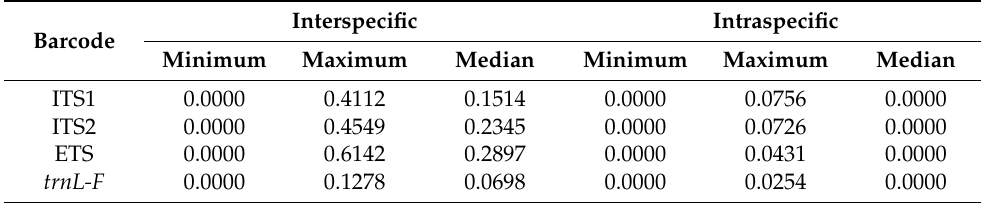
Table 5. Intra- and interspecific distance